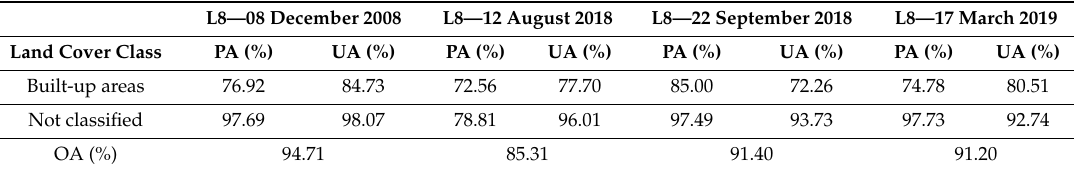
Table 18. OA, PA, and UA obtained computing SwiRed index on the images acquired by Landsat 8 mission. UA, user’s accuracy; PA, producer’s accuracy; OA, overall